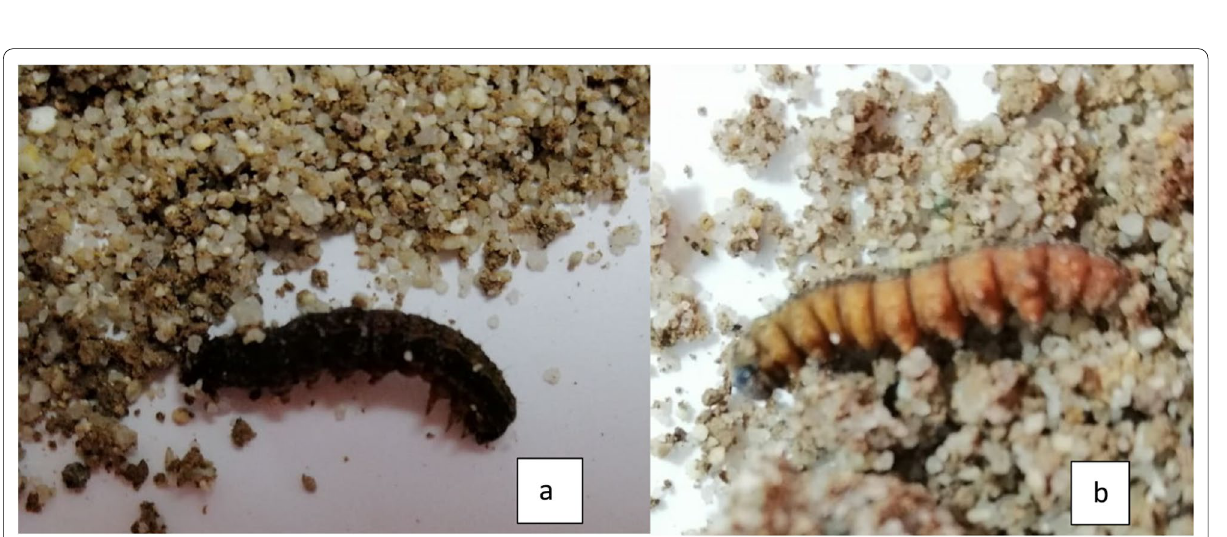
Fig. 1 Spodoptera littoralis larvae infected with Steinernematidae ( a ) and Heterorhabditidae ( b